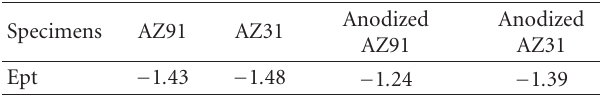
Table 2: Pitting potential measured from the anodic polarization in 17mMNaCl and 0.1MNa 2 SO 4